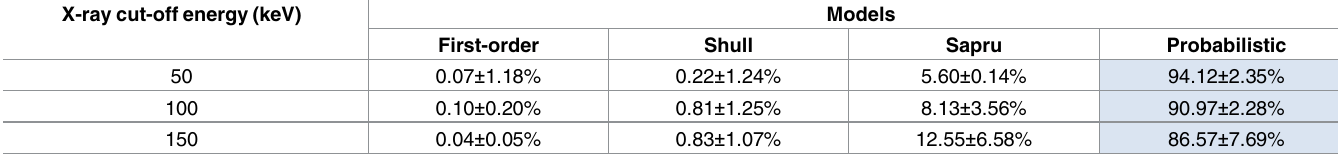
Table 3. Calculated Akaike weight values (in percentage) for the four models based on averageddata.